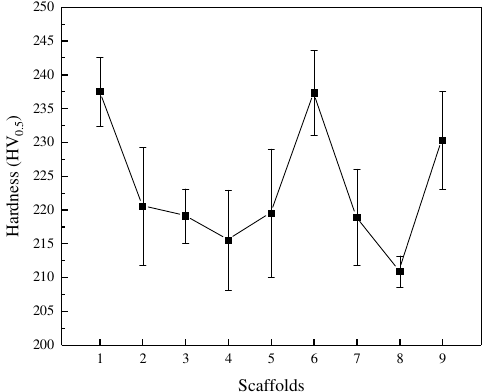
Figure 16. Hardness of the bone